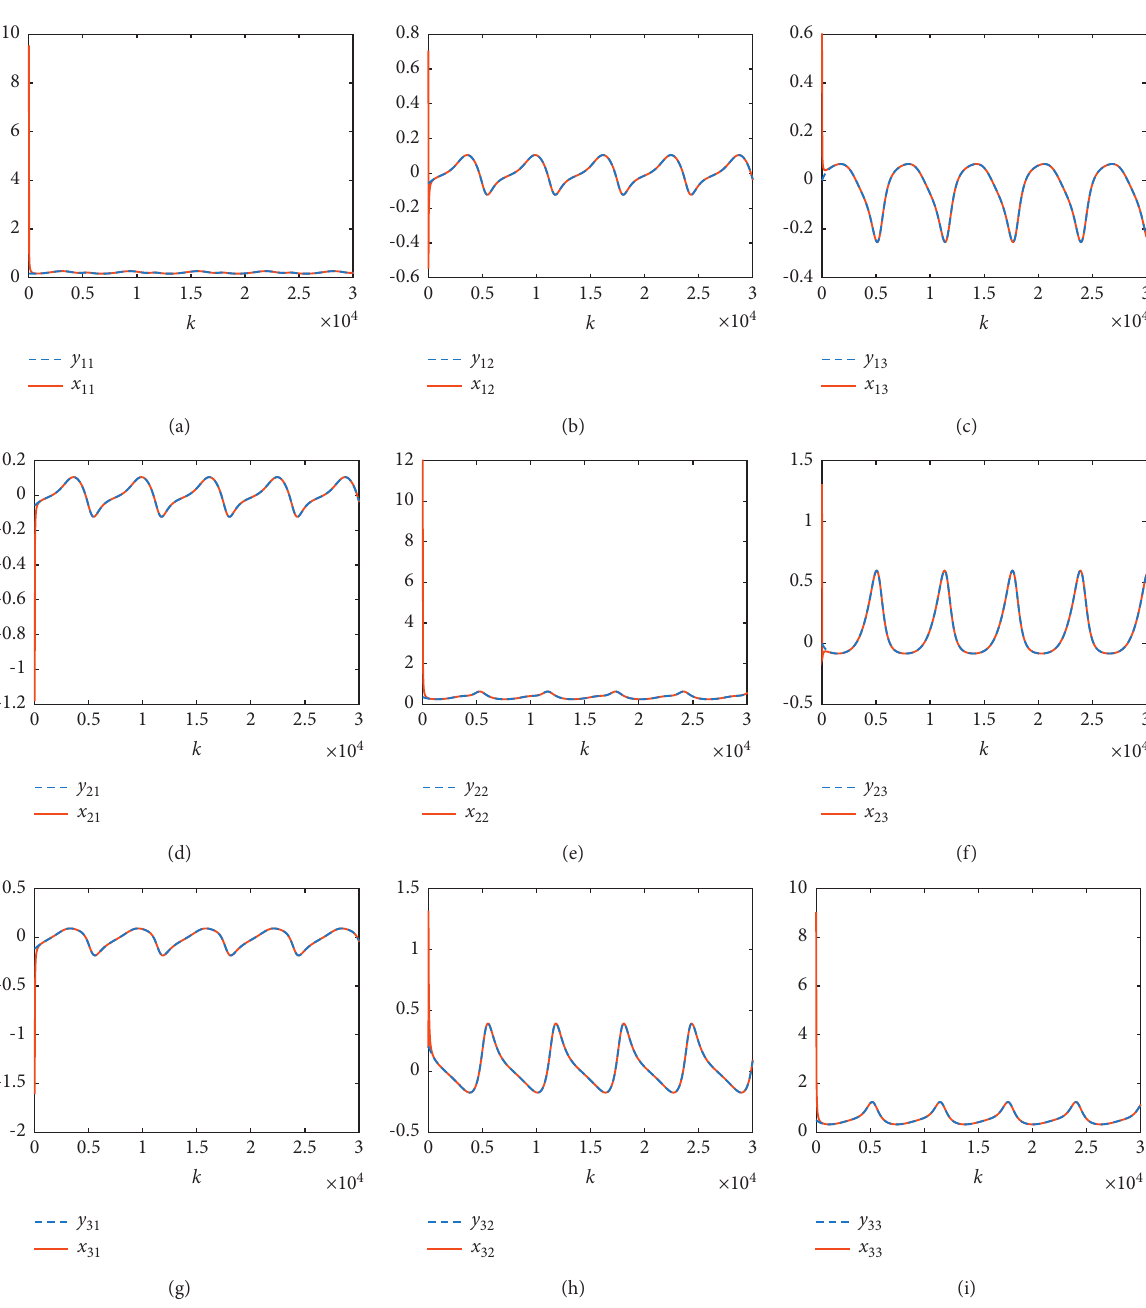
A − 1 k + 1 (i.e., k + 1 ) and by PGMDS10i algorithm (44) for example 2 (with ϵ and x . (b) Trajectories of y and x . (c) Trajectories of y 11 11 12 12